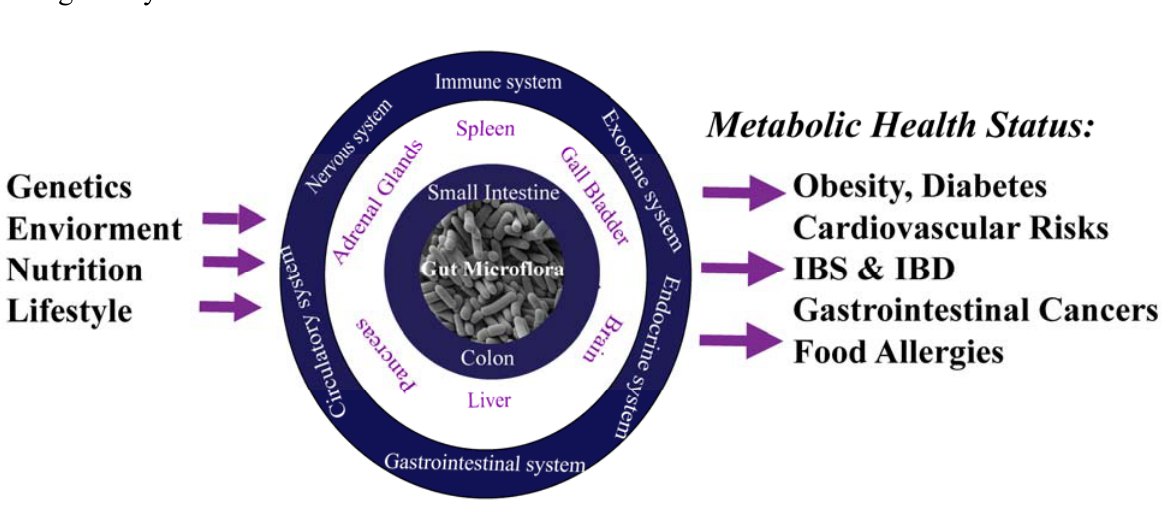
Figure 2. Scheme describing the symbiotic relationship among the host and their gut bacteria, with the gut microbiota exerting a deep control over multiple host cell metabolic regulatory